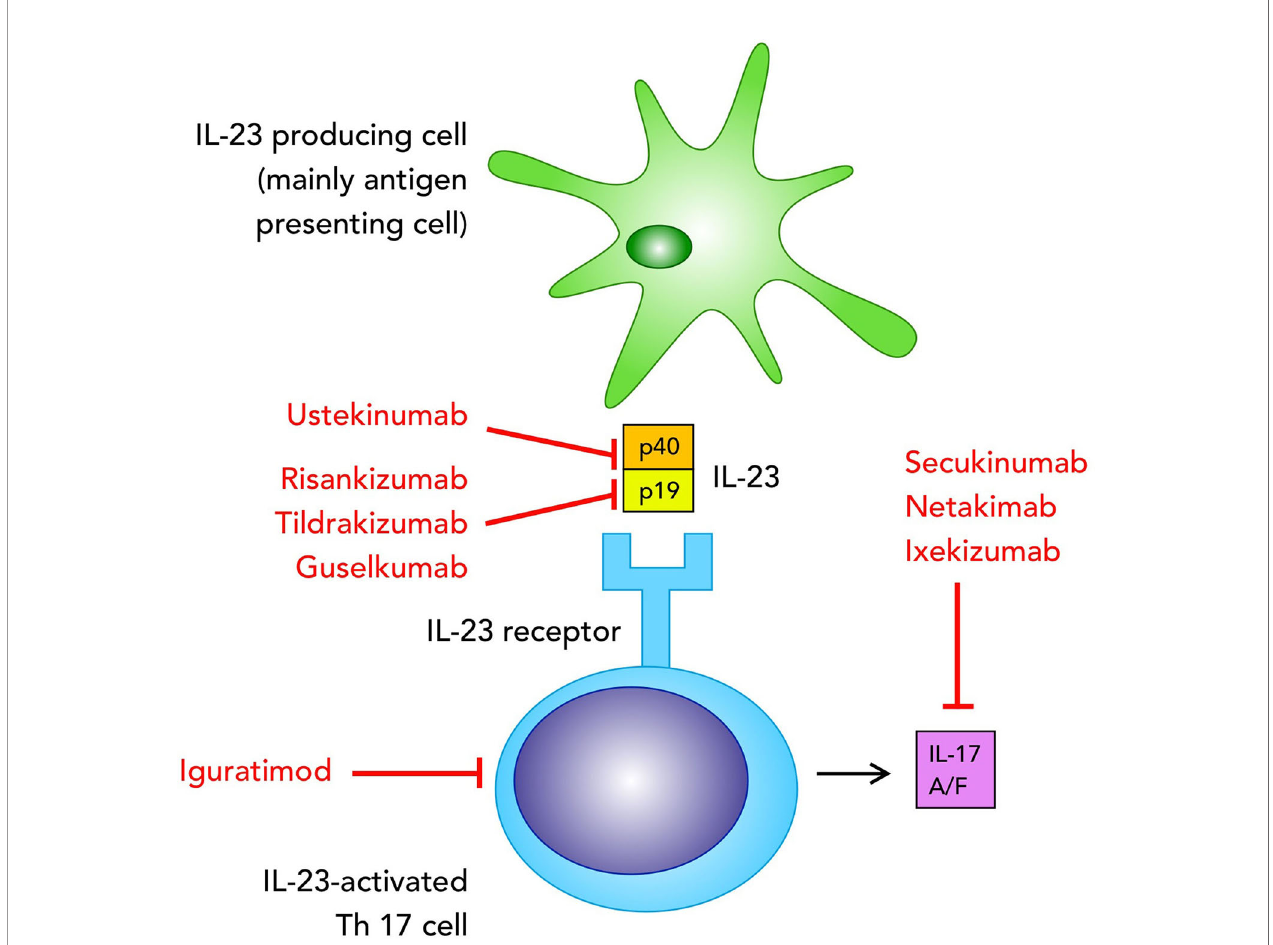
FIGURE 1 | Biologics targeting the IL-23/IL-17 pathway in axial spondyloarthritis, currently used in clinical practice or tested in clinical trials mentioned in the